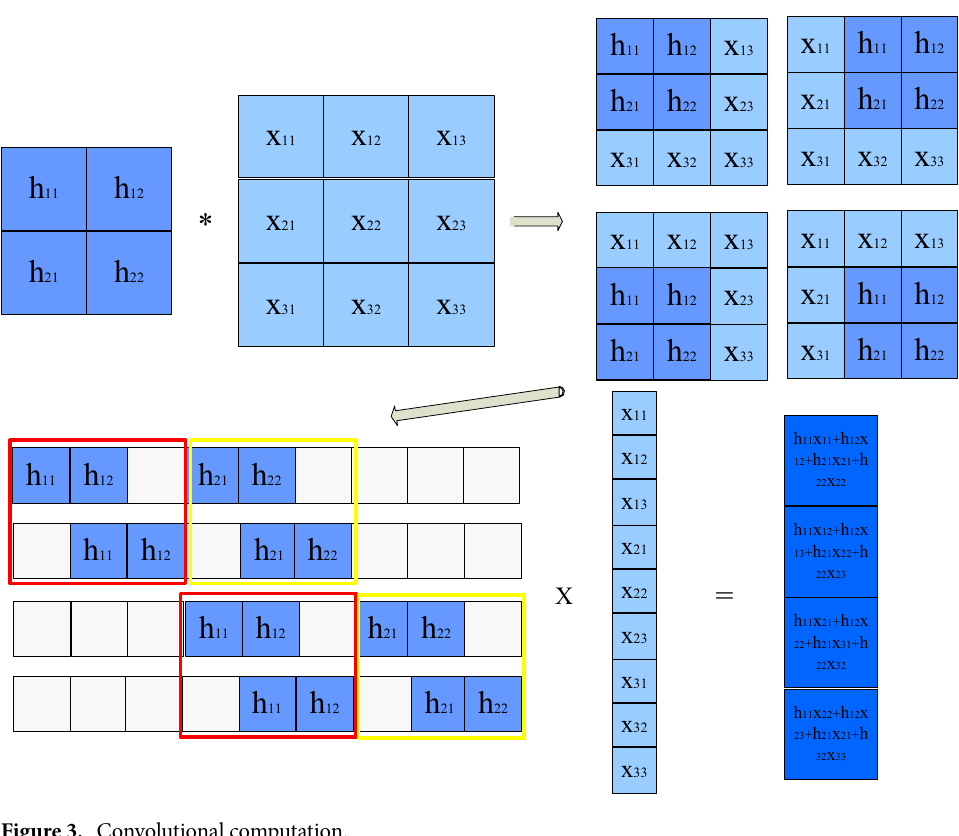
Figure 3. Convolutional